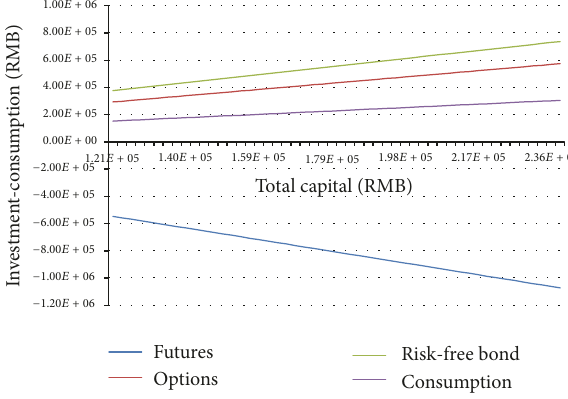
Figure 3: Optimal strategies under 𝛾 1 ≥ 𝛾 2